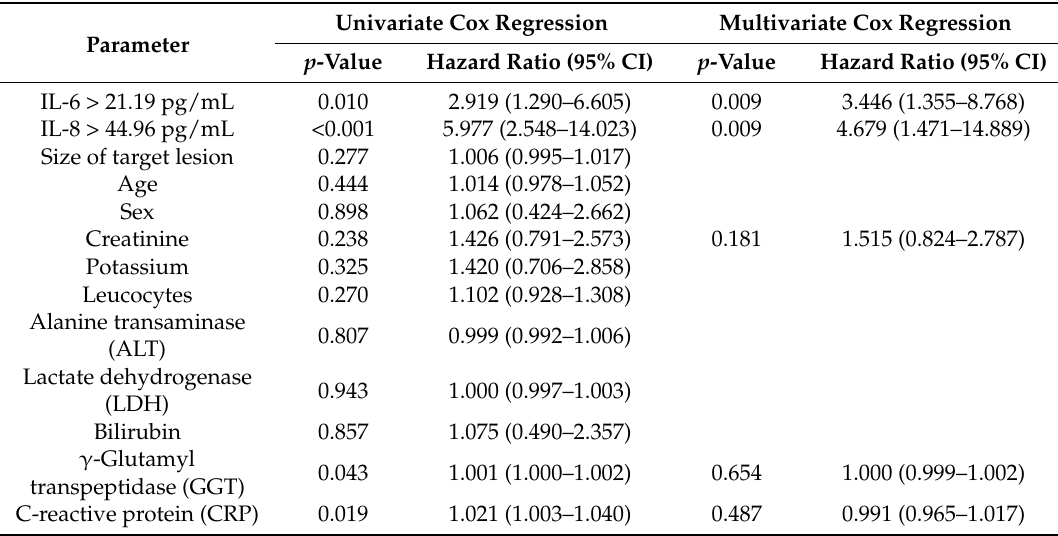
Table 2. Univariate and multivariate Cox regression analysis for the prediction of overall